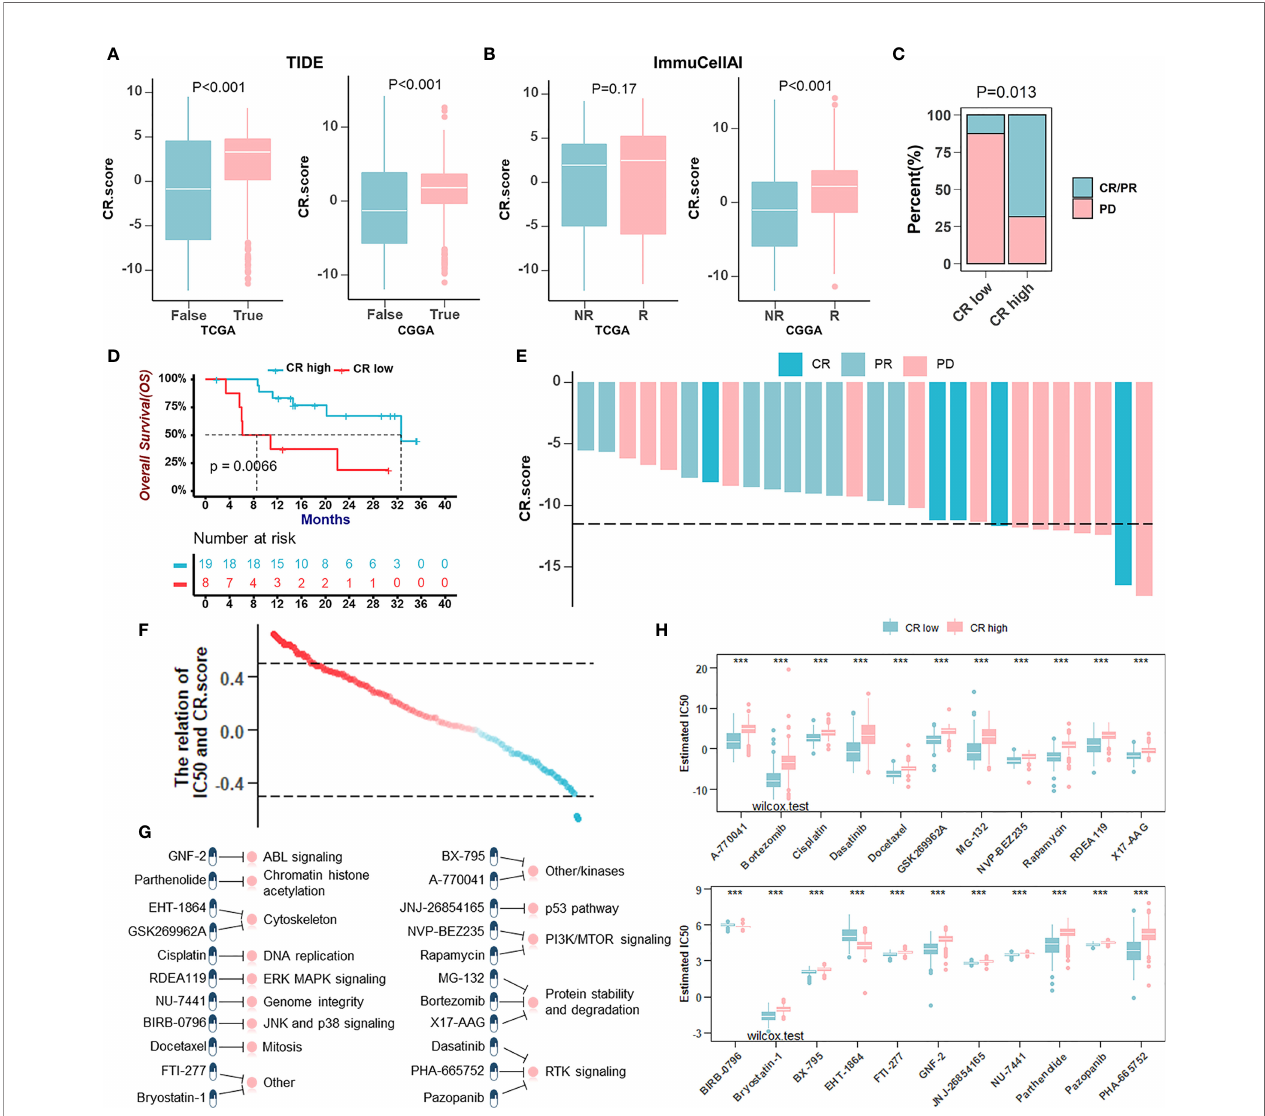
FIGURE 8 | The role of the CRscore in the prediction of therapeutic bene fi ts. (A, B) The relative distribution of TIDE (A) in TCGA ( p > 0.001) and CGGA ( p > 0.001) cohorts and ImmuCellAI (B) in TCGA ( p = 0.17) and CGGA ( p > 0.001) cohorts were compared between CR score high versus low groups, respectively. (C) The proportion of patients ’ response to PD-1 blockade immunotherapy in CR-high or -low groups. PD, progressive disease; CR, complete response; PR, partial response (Fisher ’ exact test: p = 0.013). (D) Survival analyses for low (8 cases) and high (19 cases) CR score patient groups in the anti-PD-1 immunotherapy cohort (GSE78220) using Kaplan – Meier curves (Log-Rank test: p = 0.0066). (E) The correlation of CRscore with clinical response to anti-PD-1 immunotherapy. (F) The correlation between CRscore and the estimated IC 50 for drugs evaluated by the Spearman analysis. Each point represents a drug. (G) Pathways targeted by candidate drugs. (H) The box plots of the estimated IC 50 for candidate drugs in CR-low and -high groups (Wilcoxon test: *** p <